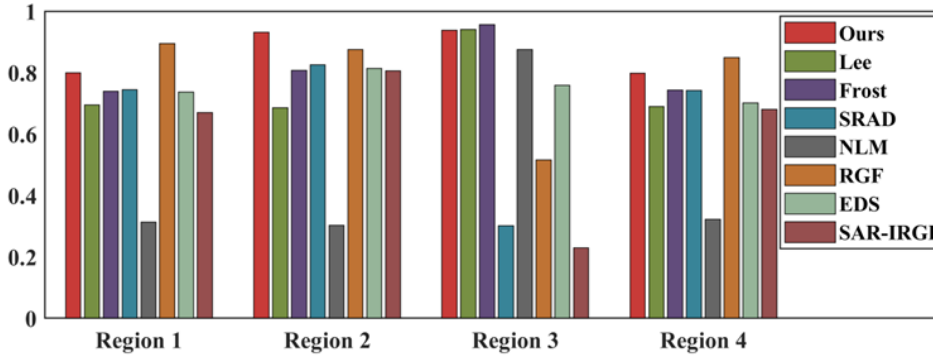
Figure 13. EPI results for the speckle suppression on synthetic image.